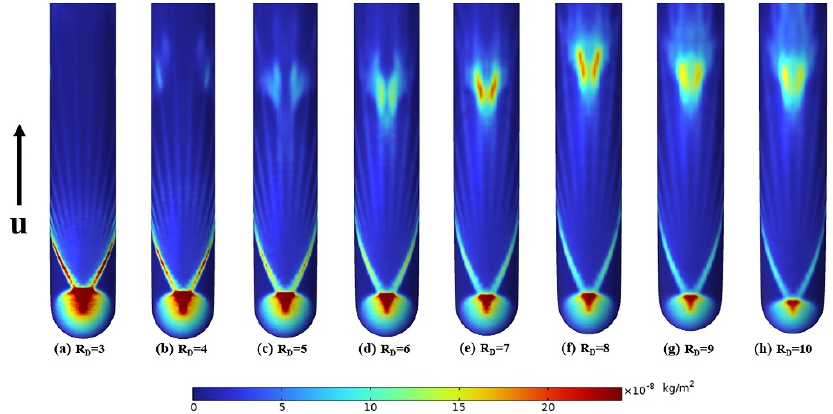
Figure 13. Erosion nephogram with different curvature ratios.